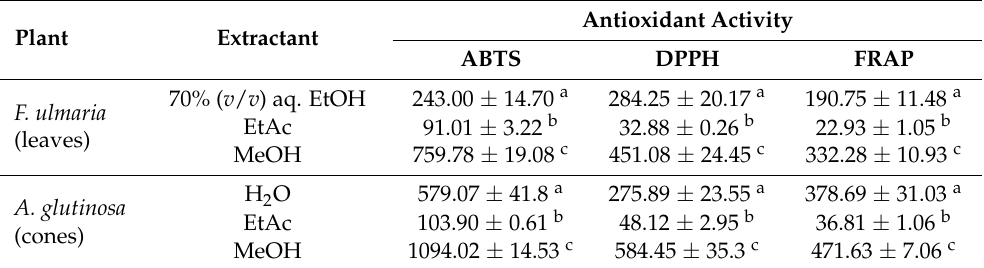
Table 3. Antioxidant activity of the extracts obtained from the aerial parts of in F. ulmaria and A. glutinosa